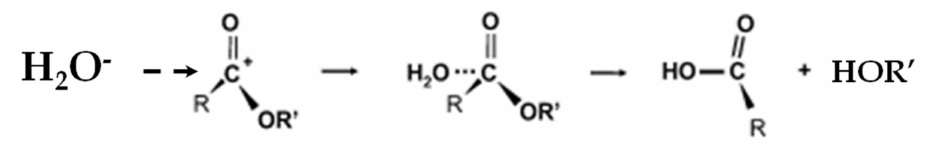
Figure 5. Scheme of nucleophilic substitution reaction, adapted from